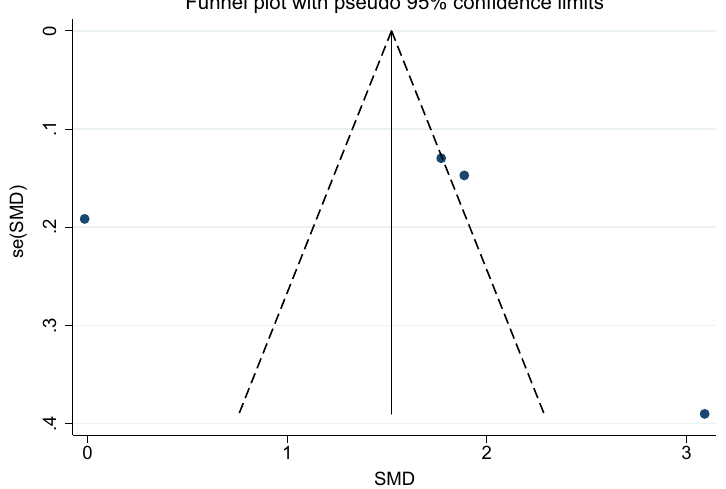
Figure 13. Funnel plot demonstrates the publication bias among 11 studies comparing the mean CRP level between patients with uncomplicated and asymptomatic malaria. SMD, standard mean difference; se, standard error.